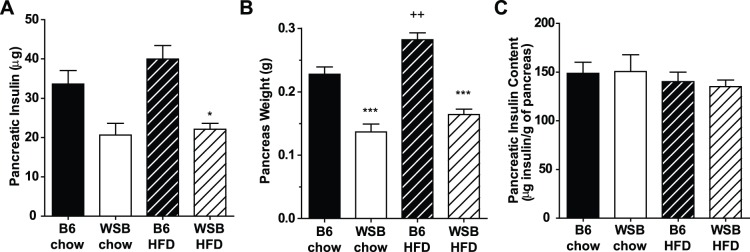
Whole pancreas insulin content.These studies were performed in young mice between 6 and 7 weeks of age. A. Total pancreatic insulin content. B. Pancreas weight. C. Pancreatic insulin content per gram of pancreas. (n = 5–6 WSB per diet, n = 10 B6 per diet) *p<0.05, ***p<0.001 vs. B6 mice consuming the same diet. ++p<0.01 vs. chow-fed mice of the same strain.